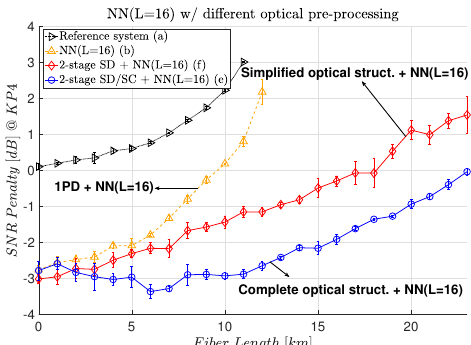
Figure 8. Simulation results to compare the hybrid two-stage SD/SC and hybrid two-stage SD/SC modules. The receiver topology considered in Figure 2 is highlighted inside the parentheses in the legend of the